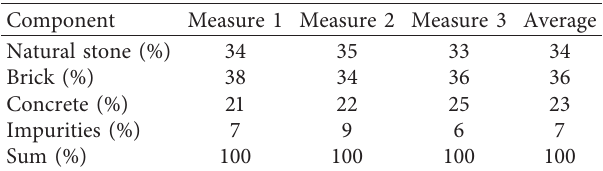
Table 1: Component percentages of the RA.